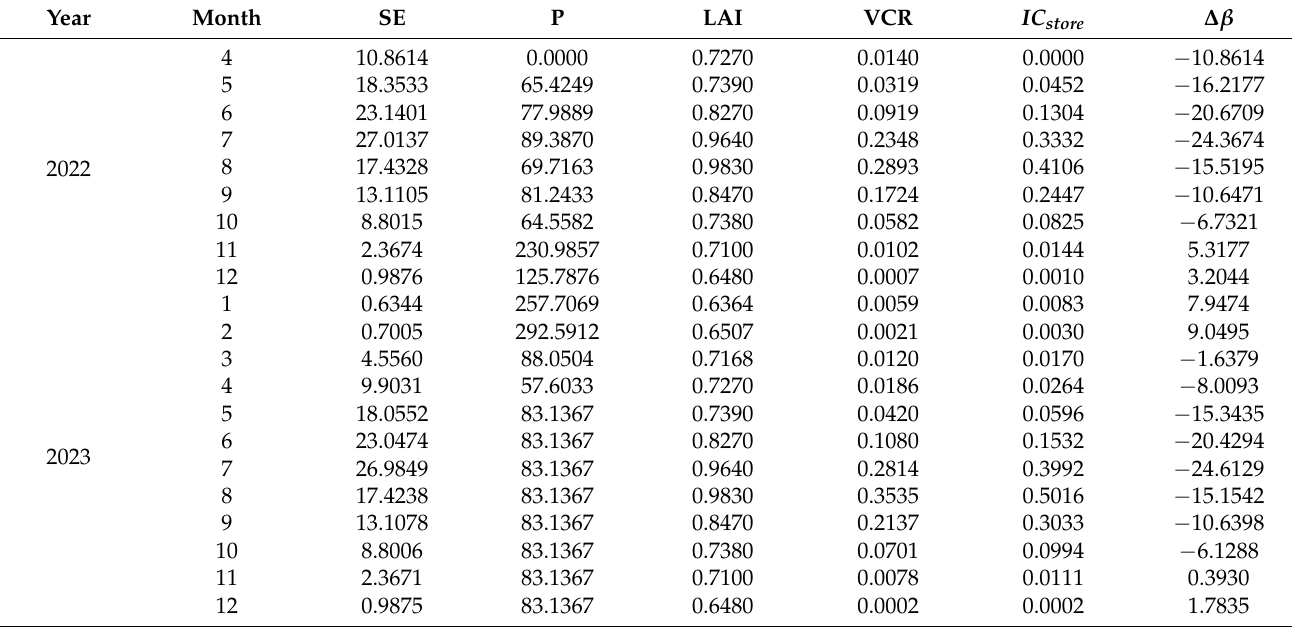
Table 5. Prediction data for SE, P, LAI and VCR, and the fitted values of 𝐼𝐶 (cid:3046)(cid:3047)(cid:3042)(cid:3045)(cid:3032) and ∆𝛽 .